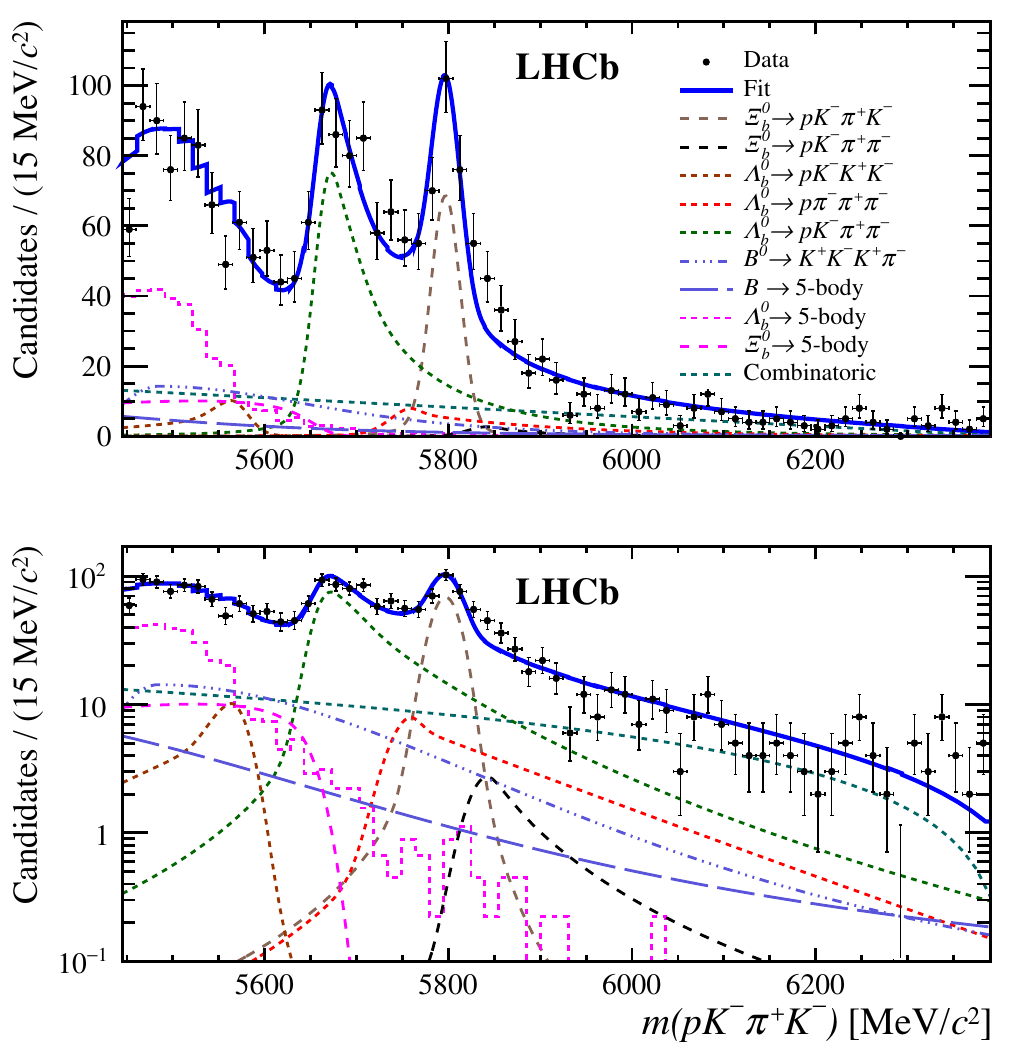
Figure 4 . Results of the (cid:12)t to the pK (cid:0) (cid:25) + K (cid:0) candidate mass spectrum with (top) linear and (bot- tom) logarithmic scales. The di(cid:11)erent components employed in the (cid:12)t are indicated in the legend. number of signal candidates vetoed by each mass criterion from a linear interpolation